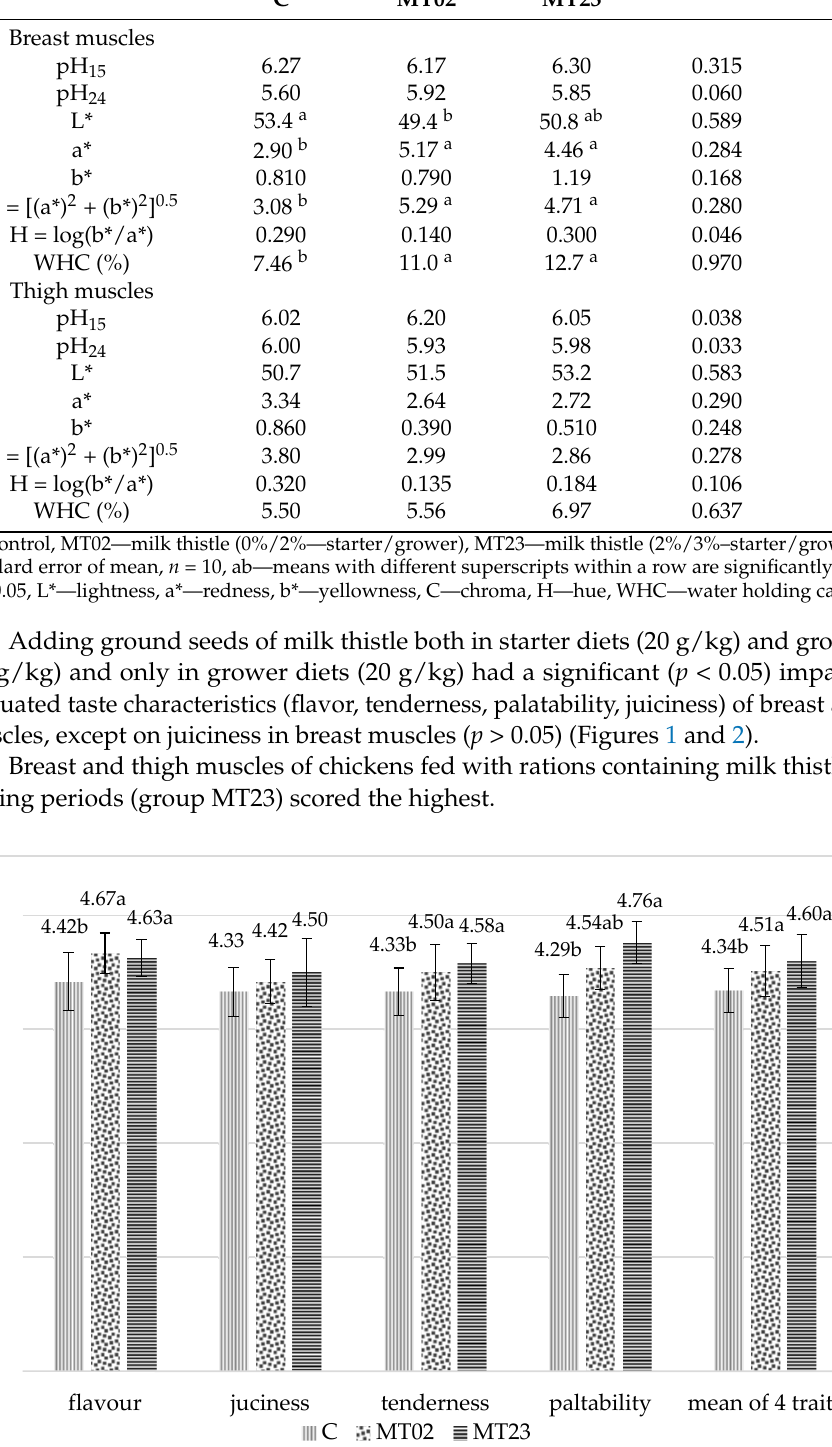
Figure 2. Sensory evaluation of thigh muscles (point). C—control, MT02—milk thistle (0%/2%— starter/grower), MT23—milk thistle (2%/3%—starter/grower), SEM—standard error of mean, n = 8, a,b—means with different superscripts within a row are significantly different at p ≤ 0.05